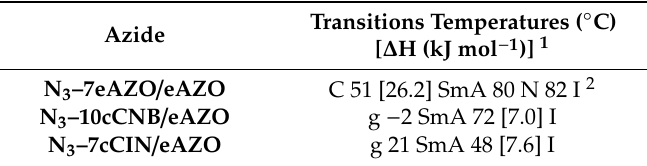
Table 1. Transition Temperatures of Azides.